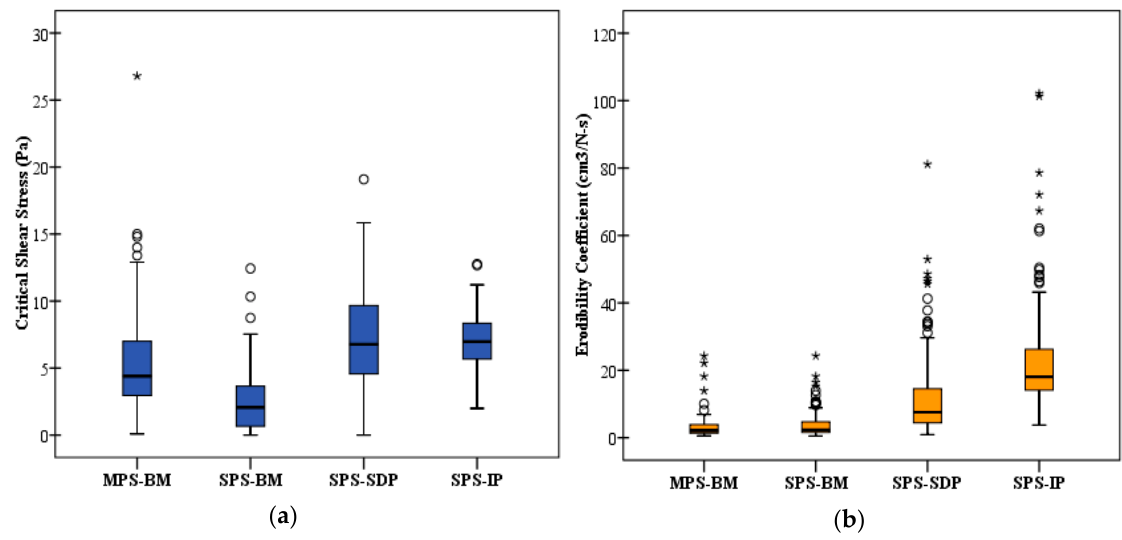
Figure 7. ( a ) Critical shear stress, and ( b ) erodibility coefficient using the field methods and computation